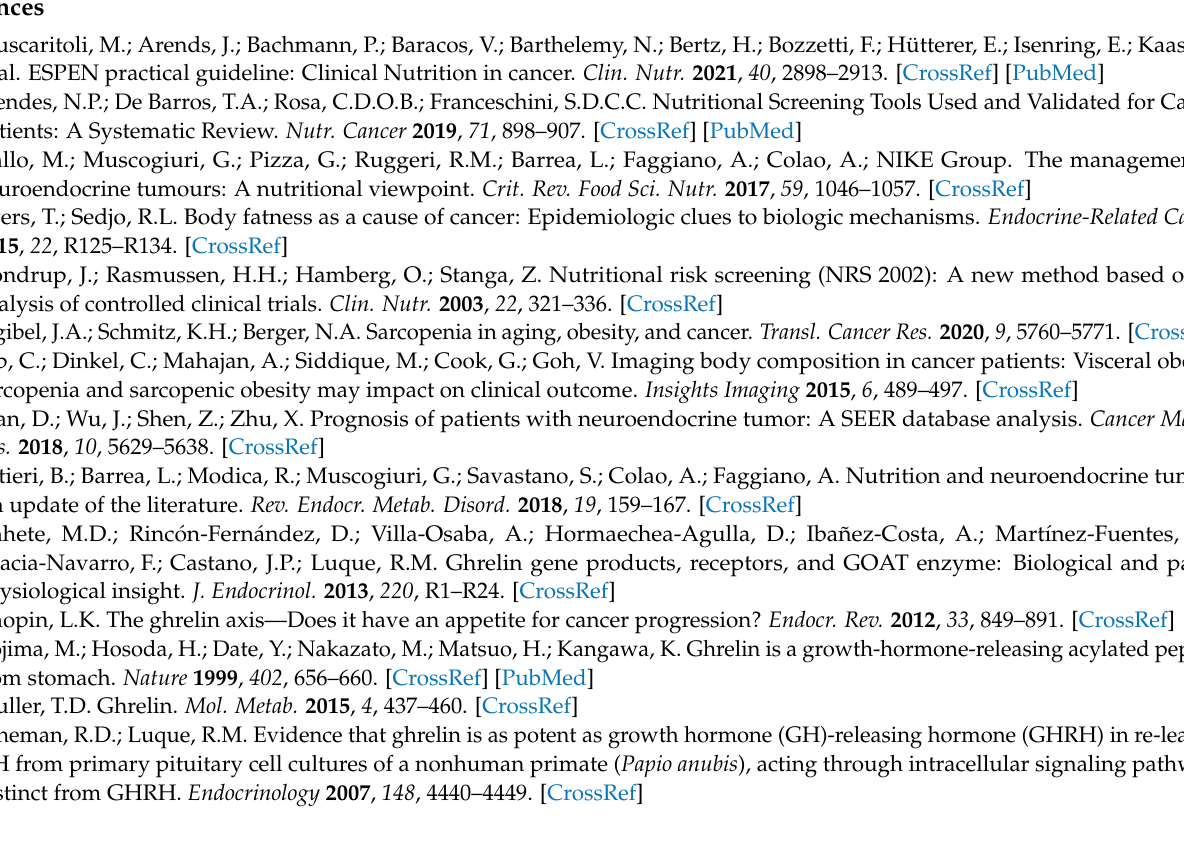
(E) serum total cholesterol; (F) BMI. Table S1. Prevalence of altered nutritional parameters in patients with NEN at diagnosis according to tumor grade. Table S2. Log rank of cumulative survival curves for NEN patients according to nutritional parameters: (A) weight loss, metastasis and serum albumin levels at diagnosis; (B) BMI and other biochemical nutritional